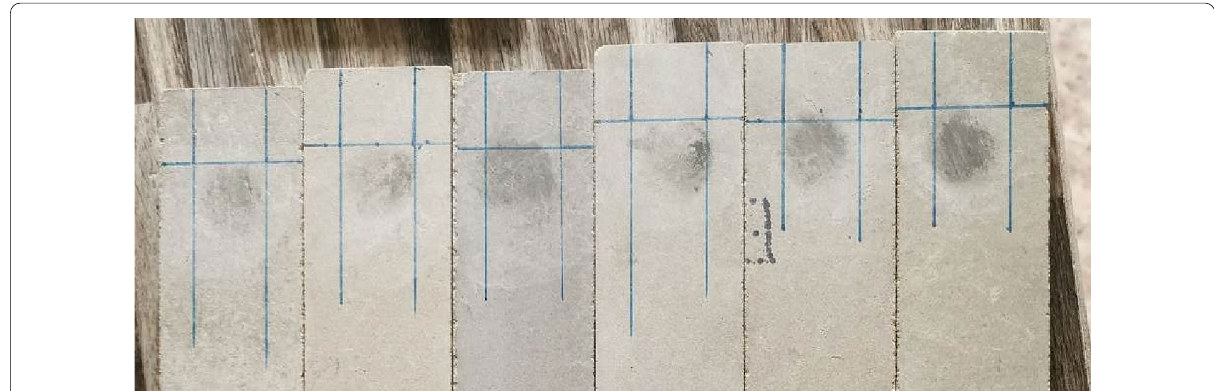
Fig. 10 Representative SE of test specimens after finishing the 4th cycle in accordance with EN321 and after determination of time of passage of ultrasonic